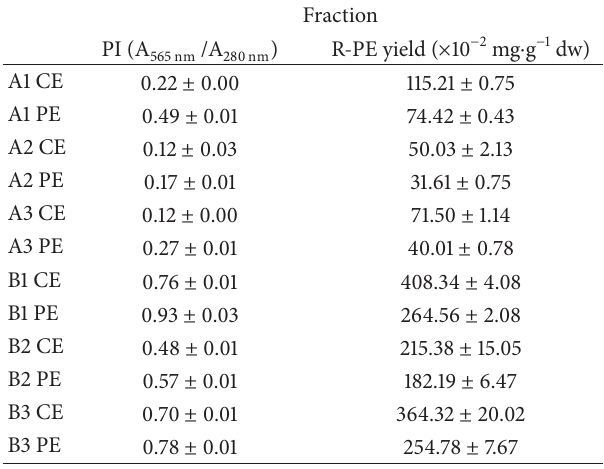
Table 2: Purity index (PI) and yields of crude extracts and protein extracts from samples from sites A and B and following the three storage